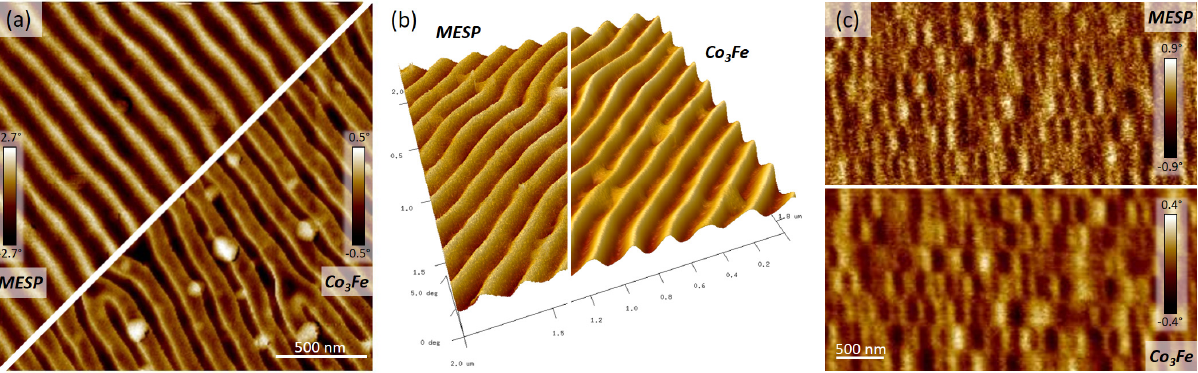
Figure 7. MFM ‐ map comparison between well ‐ established commercial MFM tips (MESP, Bruker) and FEBID Co 3 Fe α‐ pillars for the CoPt sample ( a , b ) and a magnetic hard disc drive ( c ), revealing sharper features and reduced noise. The latter is also evident in ( b ) by 3D representations of MFM maps on a CoPt sample, which are vertically adapted to achieve a similar 3D effect.